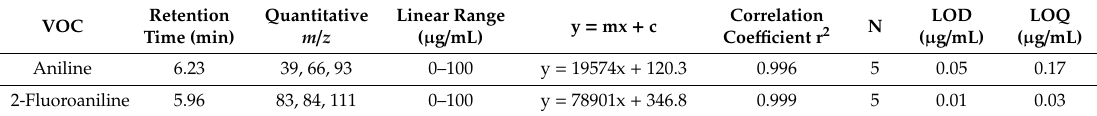
Table 1. Analytical figures of merit for volatile organic compound (VOC) quantitation.